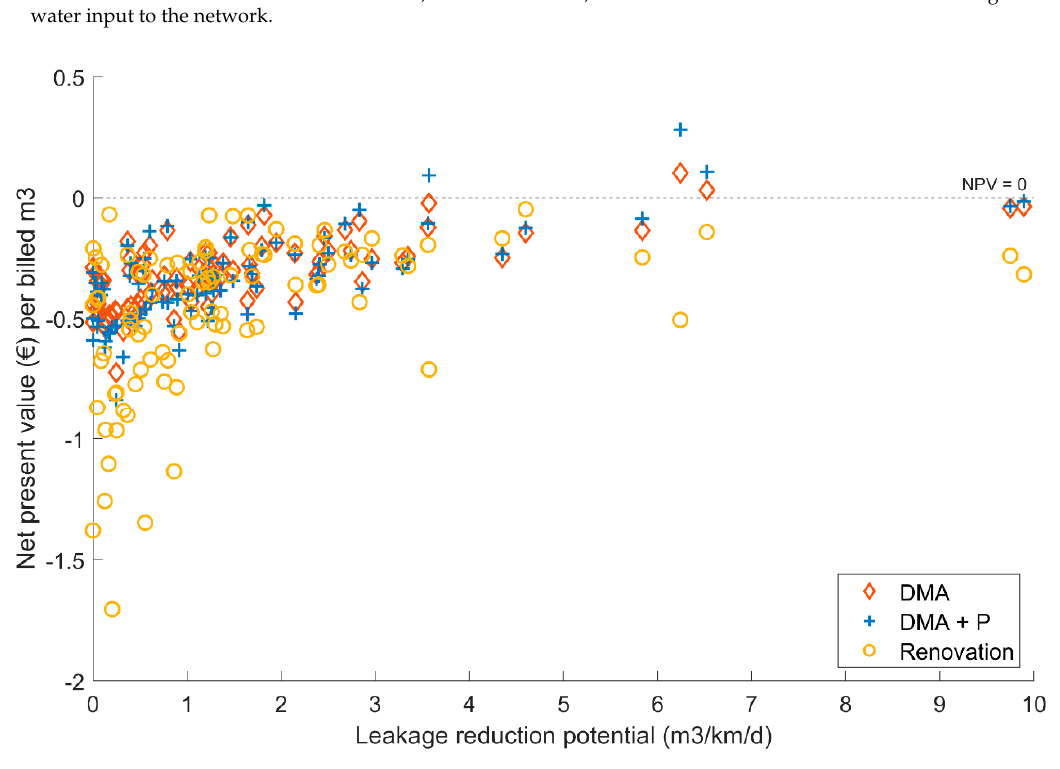
Figure 3. Net present values per volume of billed water (euros/m 3 ) for the leakage reduction measures: (1) district metered areas (DMA), (2) district metered areas with pressure reduction (DMA + P), and (3) renovations plotted against the leakage reduction potential (m 3 /km/d).